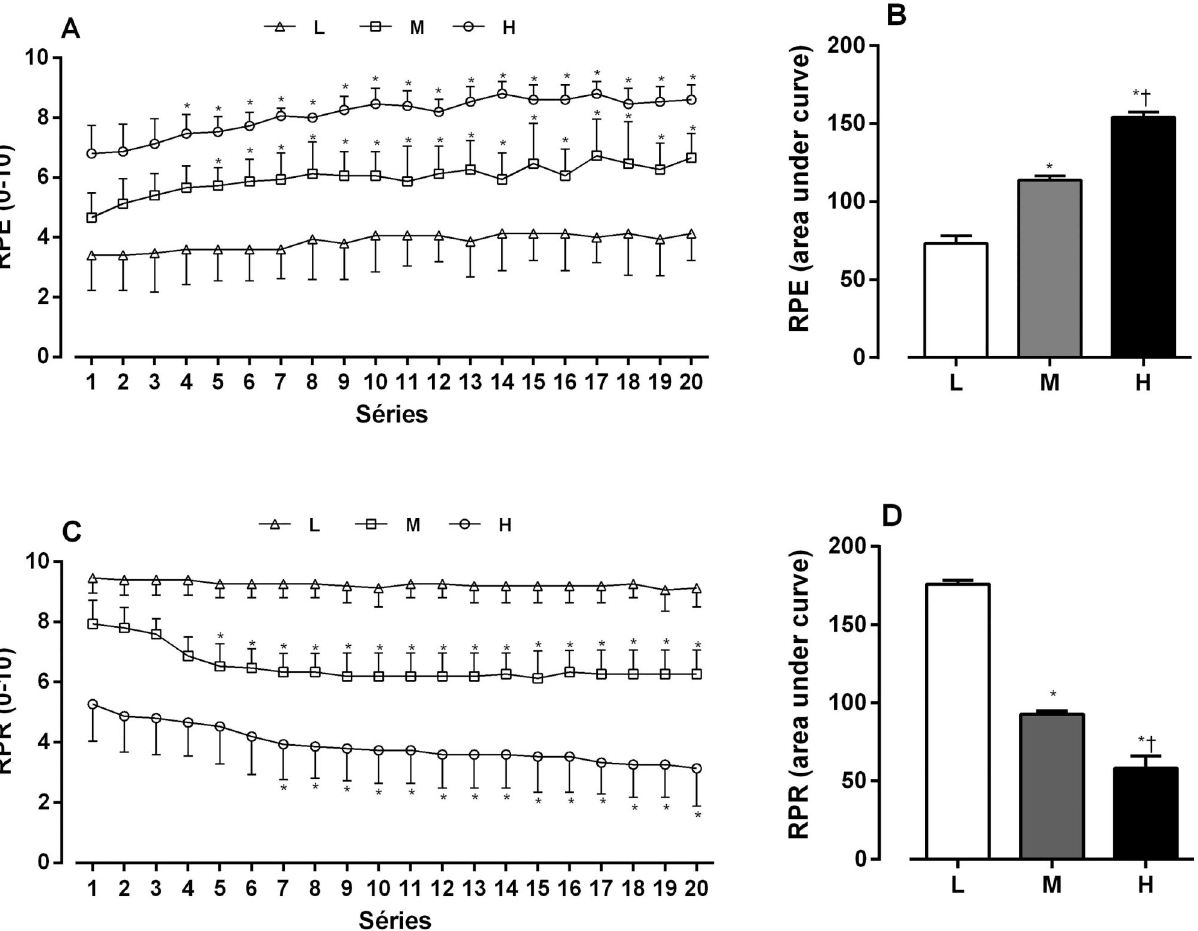
Figure 3 - Values expressed as mean ± standard deviation of feeling scale before and after carrying out the protocols of low (L), moderate (M), and high (H) cadences of the rate of perceived exertion (RPE; Panel A) and recovery (RPR; Panel C) and respective area under the curve of RPE (Panel B) and RPR (Panel D). *p < 0.01 vs. first set-top Panel A and C. *p < 0.01 vs. L. † p < 0.01 vs. M to Panel B and D.